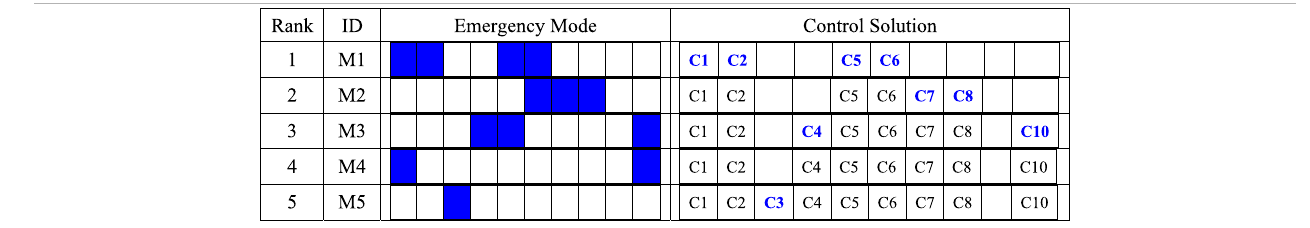
TABLE 4 | Combining of control